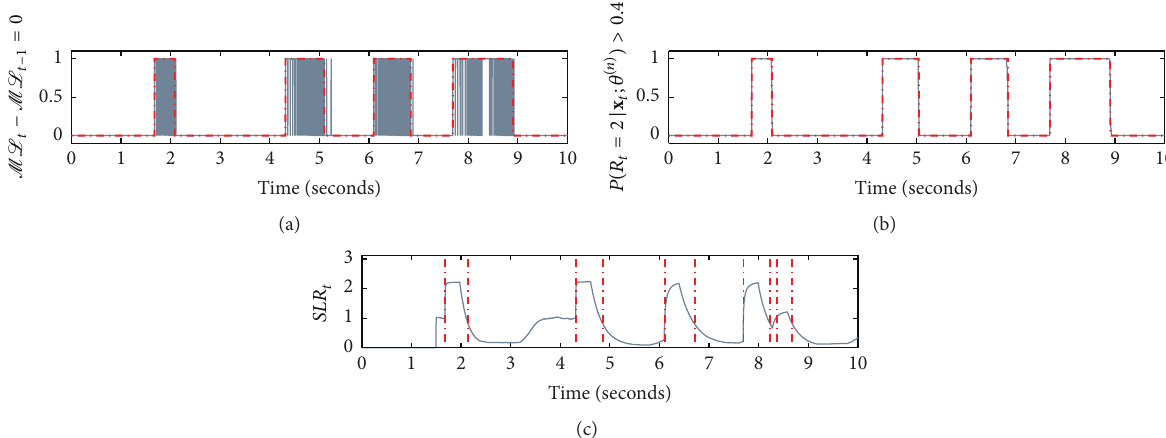
Figure 7: The application of the discussed methods to the multievent time series, presented in Figure 5(b). The final segments have been marked by using bold red-dashed curves. (a) The application of the smoothing procedure used for segmentation purposes based on ML 𝑡 statistics. The grey curve depicts the nonsmoothed segments. (b) The application of the smoothing procedure to the vector of probabilities of being in the second regime with the boundary threshold set to 0.4. The grey curve denotes the nonsmoothed vector of probabilities. (c) Sequence of the test statistics 𝑆𝐿𝑅 𝑡 , where the short and long time windows are equal to 0.3 s and 1.5s, respectively; the activation 𝜏 𝐴 and deactivation 𝜏 𝐷 thresholds correspond to 1.05 and 0.8, respectively.